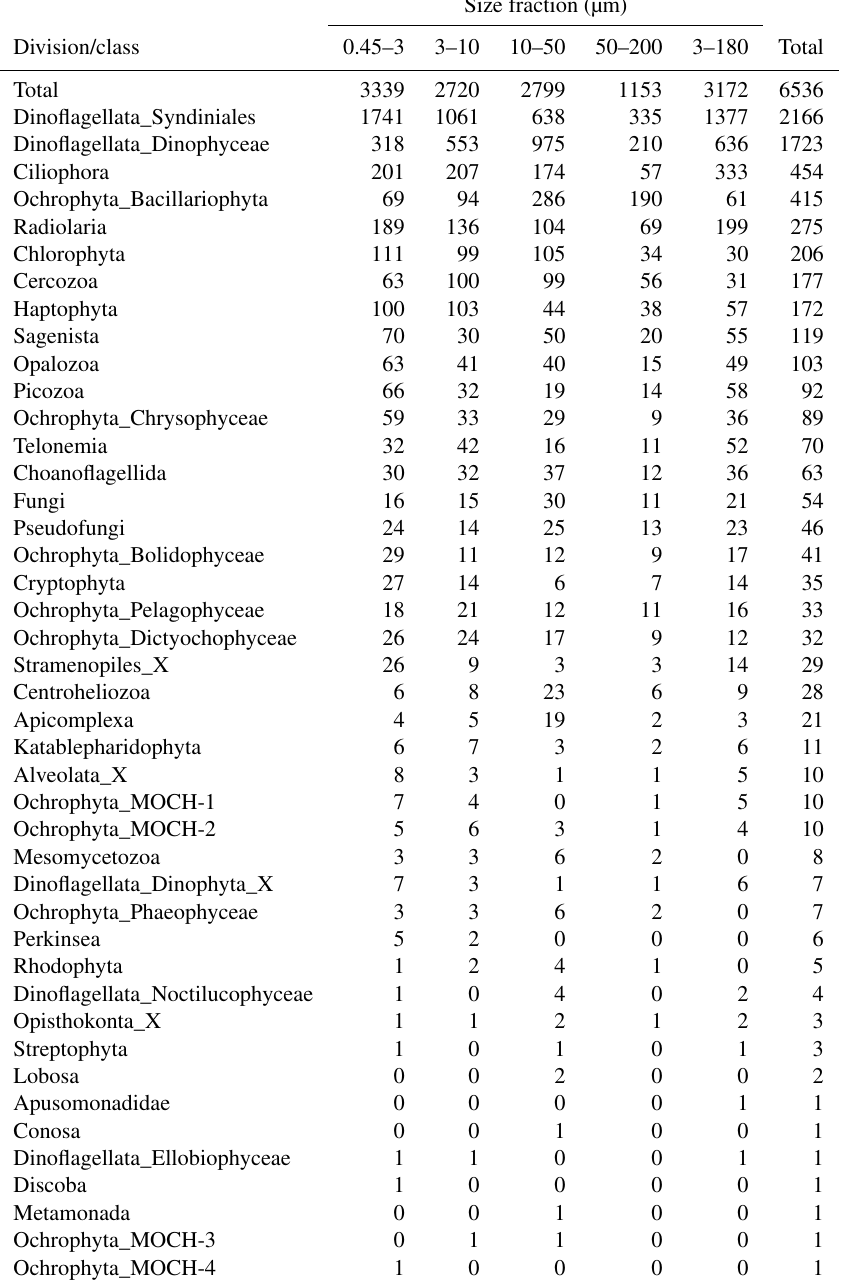
Table A1. Number of ASVs assigned to each division or class, distributed by size fraction, and in total. Note that a given ASV may occur in multiple size fractions. Number of samples in each size fraction: 0.45–3µm: 44; 3–180µm: 18; 3–10µm: 26; 10–50µm: 33; and 50–200µm: